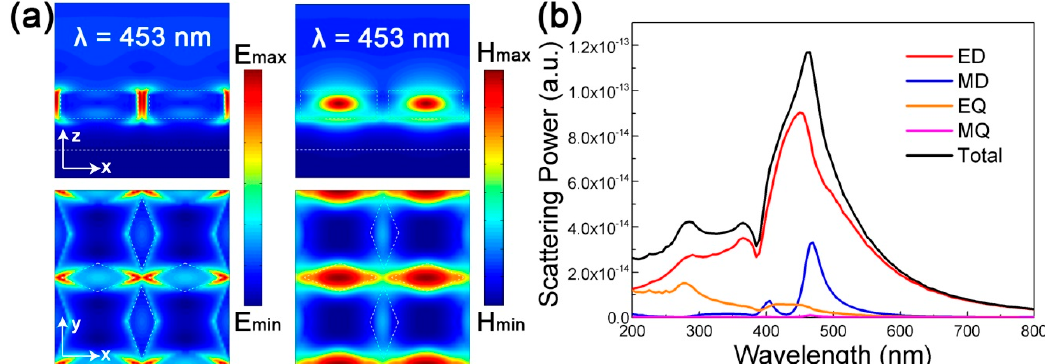
Figure 3. ( a ) The electric and magnetic field distributions for the proposed DBMPA at the absorption peak of 453 nm along the xoy and xoz plane; ( b ) scattering power of the multipoles as a function of the wavelength, where the resonator with semi-major axis is 110 nm and semi-minor axis is 40 nm, the contributions of the electric dipole (ED), magnetic dipole (MD), electric quadrupole (EQ), and magnetic quadrupole (MQ) to the total scattering are revealed.